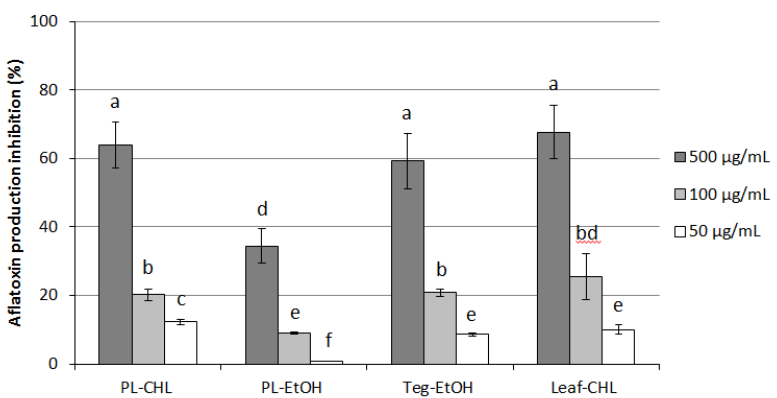
Figure 5. Anti-aflatoxigenic activity of chloroform (PL-CHL) and ethanol (PL-EtOH) extracts of C. colocynthis plantlets, mature leaf (Leaf-CHL), and seed coat (Teg-EtOH) at increasing concentrations. Values are means of four replicates and are expressed as inhibition percentage with respect to control ± S.D. Different superscript letters indicate statistically significant differences ( p < 0.005).